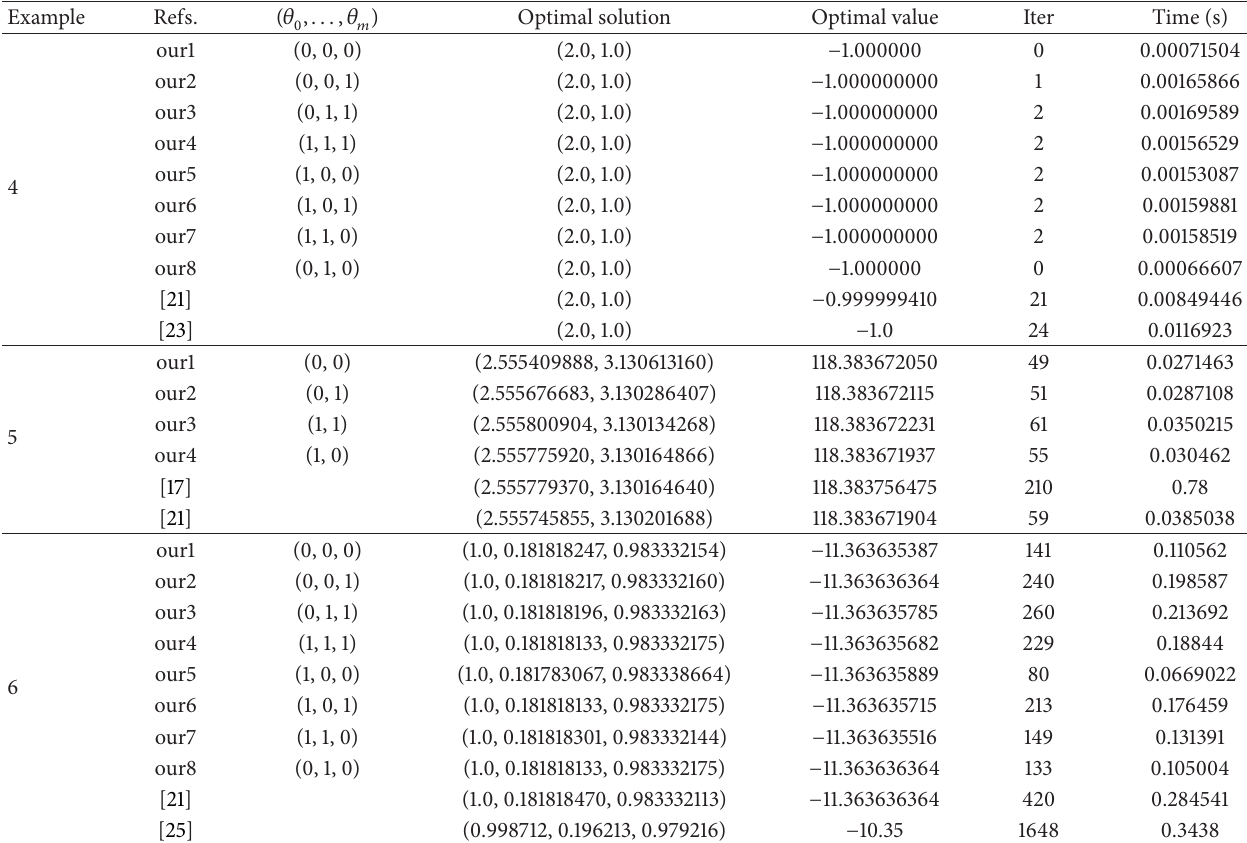
Table 2: Numerical results for Examples 4–6.